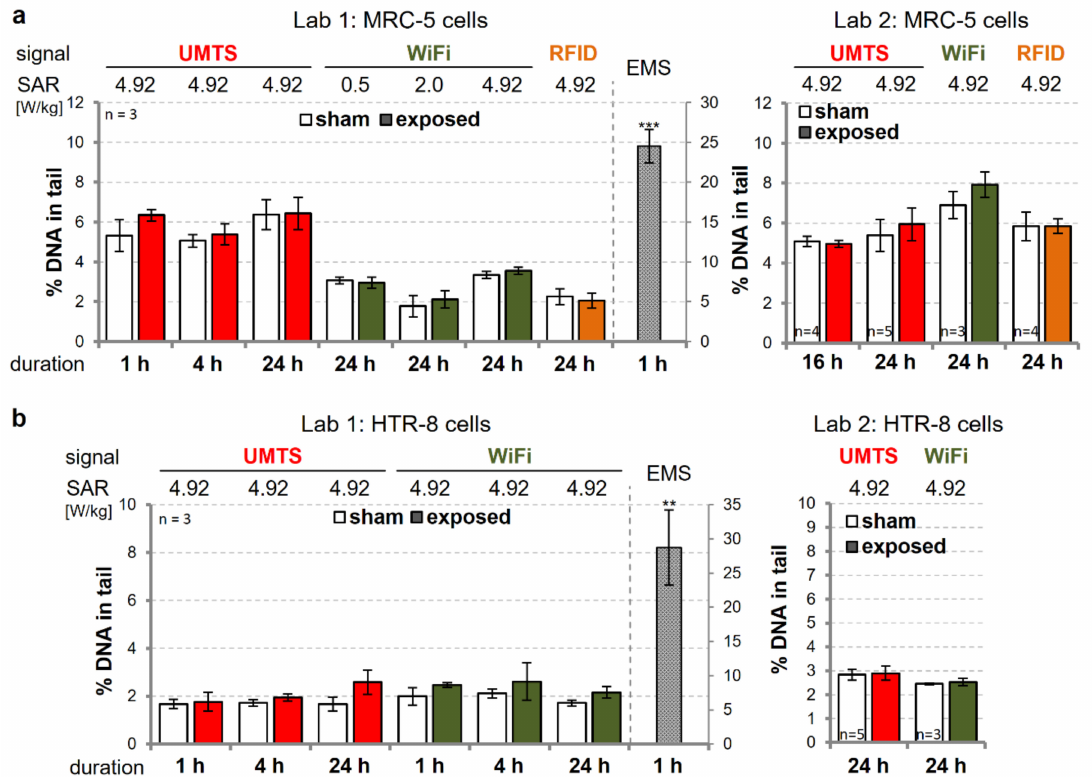
Figure 2. Genotoxicity assessment by CA of modulated electromagnetic fields relevant for wireless communication (wEMF) in human cells. Primary MRC-5 lung fibroblasts ( a ) and immortalized HTR-8 / SVneo (HTR-8) trophoblasts ( b ) were exposed to indicated doses of intermittent (5 / 10 min on / o ff ) wEMF signals (colored bars by signal type) or sham-exposed (white bars) for the duration indicated. Applying standardized experimental procedures, DNA damage was assessed by the alkaline CA, independently executed in two laboratories (compare left and right panels). As a positive control, cells were treated with 0.5 µ L / mL ethyl methanesulfonate (EMS) for 1 h, concomitant to wEMF exposure. Data represent arithmetic means ± SEM of independent experiments ( n ). Asterisks indicate significance levels of Student’s t -test comparing wEMF-exposed and EMS-treated cells with sham-exposed samples: ** p < 0.01; *** p <